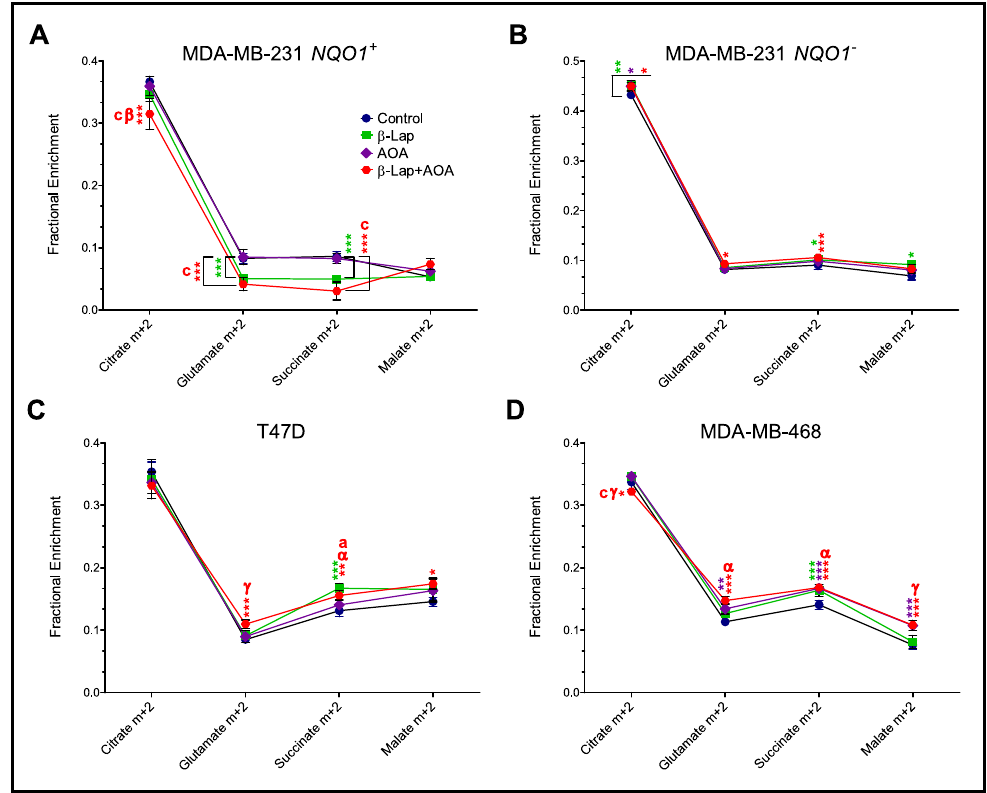
Figure 5. Assessment of TCA cycle activity by measuring isotopologue labeling in TCA cycle metabolites revealed differences in the fractional enrichment of the m+2 isotopologues of citrate, glutamate, succinate, and malate in MDA-MB-231 NQO1 + (Panel ( A )), MDA-MB-231 NQO1 − (Panel ( B )), T47D (Panel ( C )), and MDA-MB-468 (Panel ( D )). Results were calculated from intracellular GC-MS data and corrected for natural isotope abundance using the Isotopomer Network Compartmental Analysis (INCA 2.0) software. (Note: n = 3, biological replicate data are represented as mean ± SD.